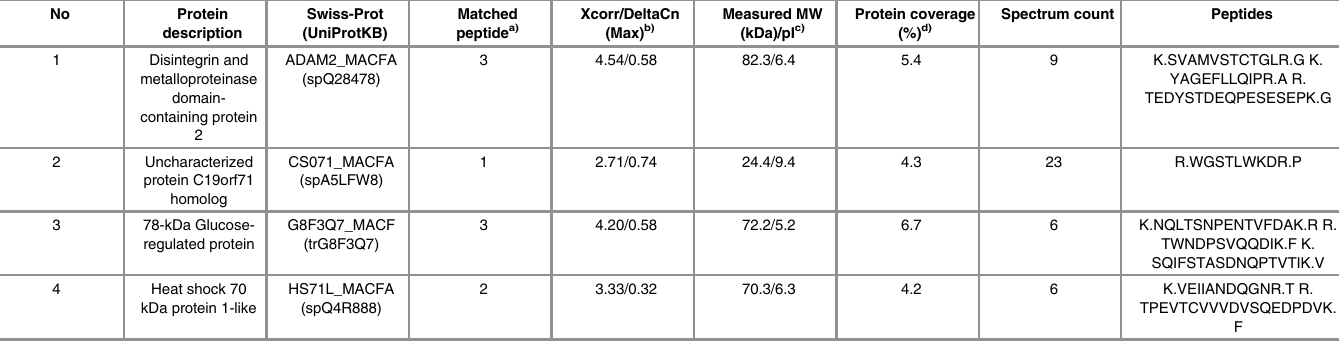
Table 2. Monkey ADAM2-coimmunoprecipitated proteins identified by LC-MS/MS analysis.